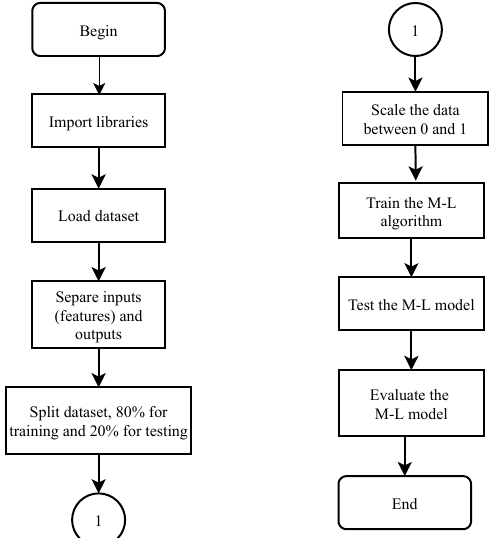
Figure 10. Flowchart for training and testing of ML